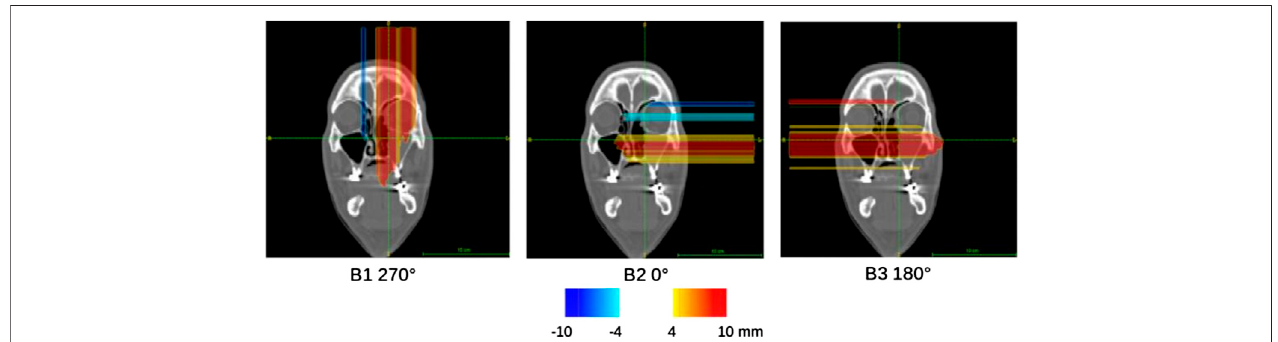
FIGURE 7 | Compliance maps referring to the activity image analysis for each beam fi eld (B1, B2, B3) of the MCP patient, overlaid on the planning CT with the proposed CLUT.